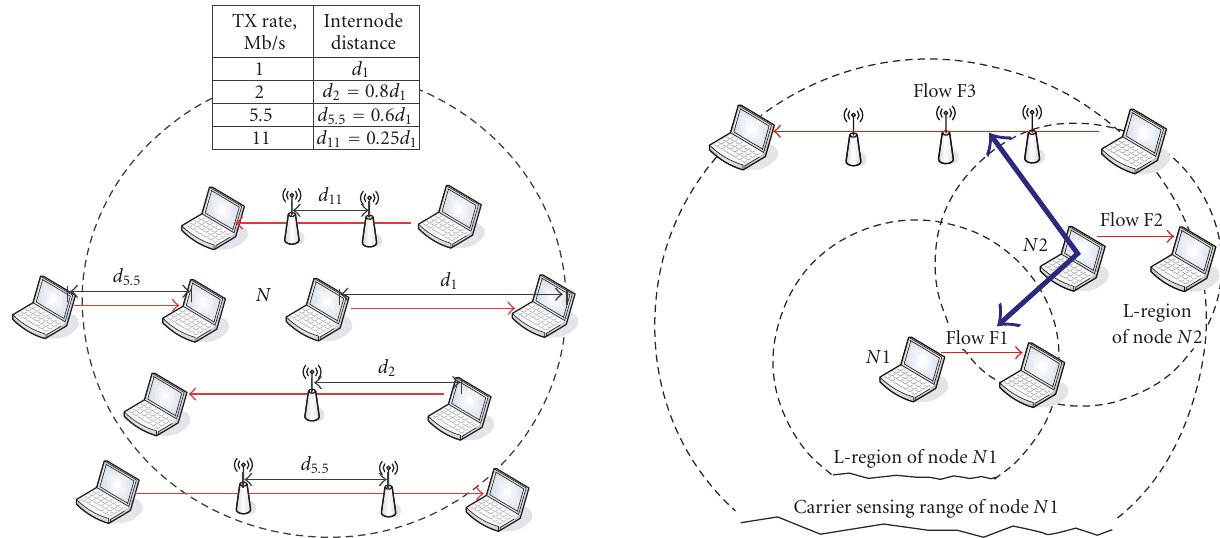
Figure 1: Illustration of the L-region